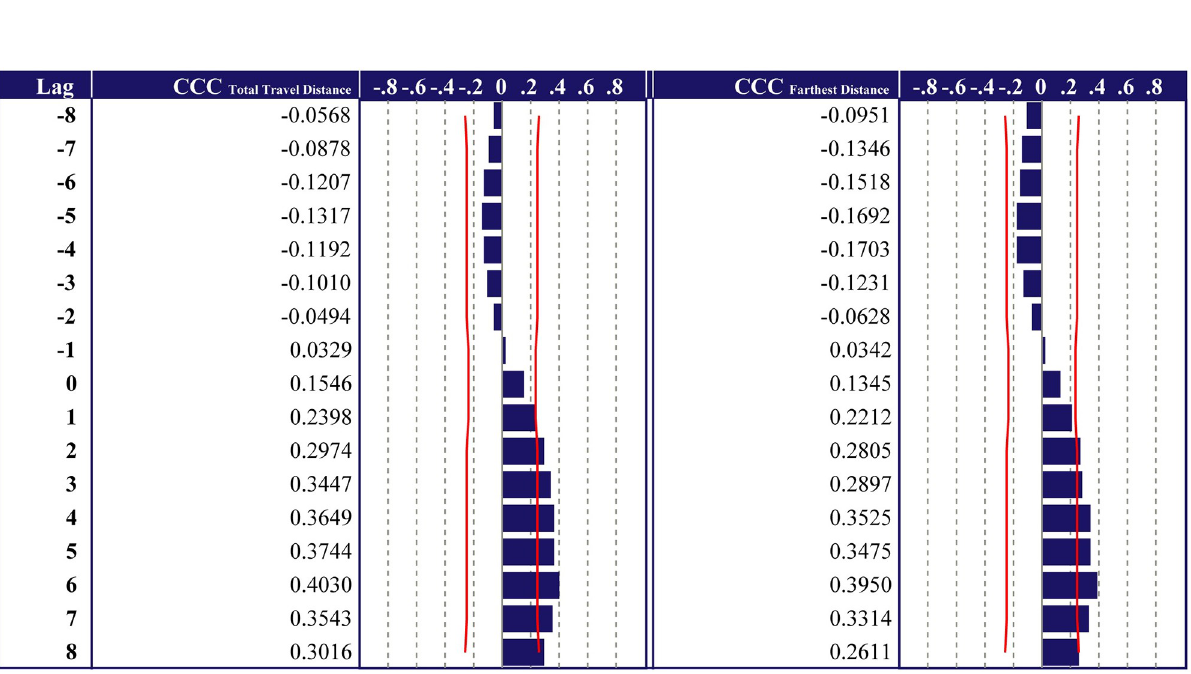
Fig 6. Cross-correlation of home range lengths and the number of infected people. CCC Total Travel Distance is HR-length (Total Travel Distance). CCC Farthest Distance is HR-length (Farthest Distance). In cross-correlation, the lag was set to eight weeks.